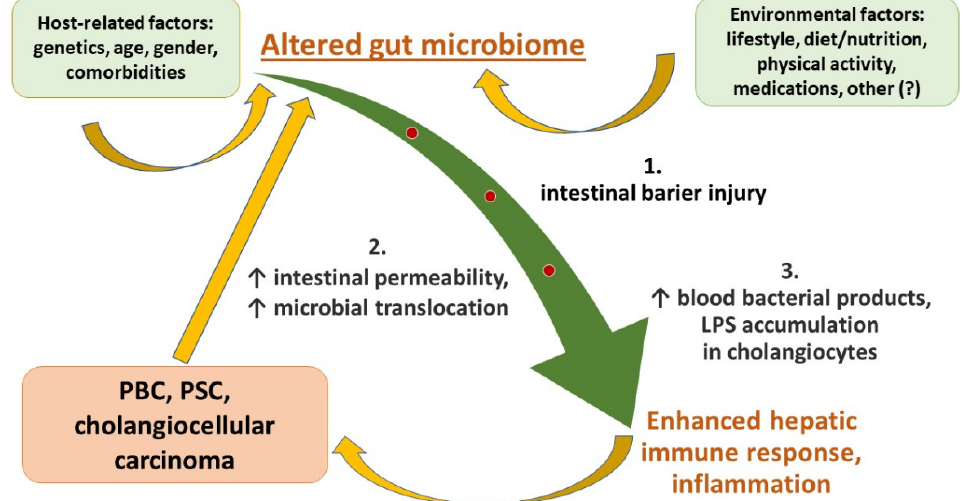
Figure 1. The vicious circle of gut–liver crosstalk in the course of immune-related cholangiopa-